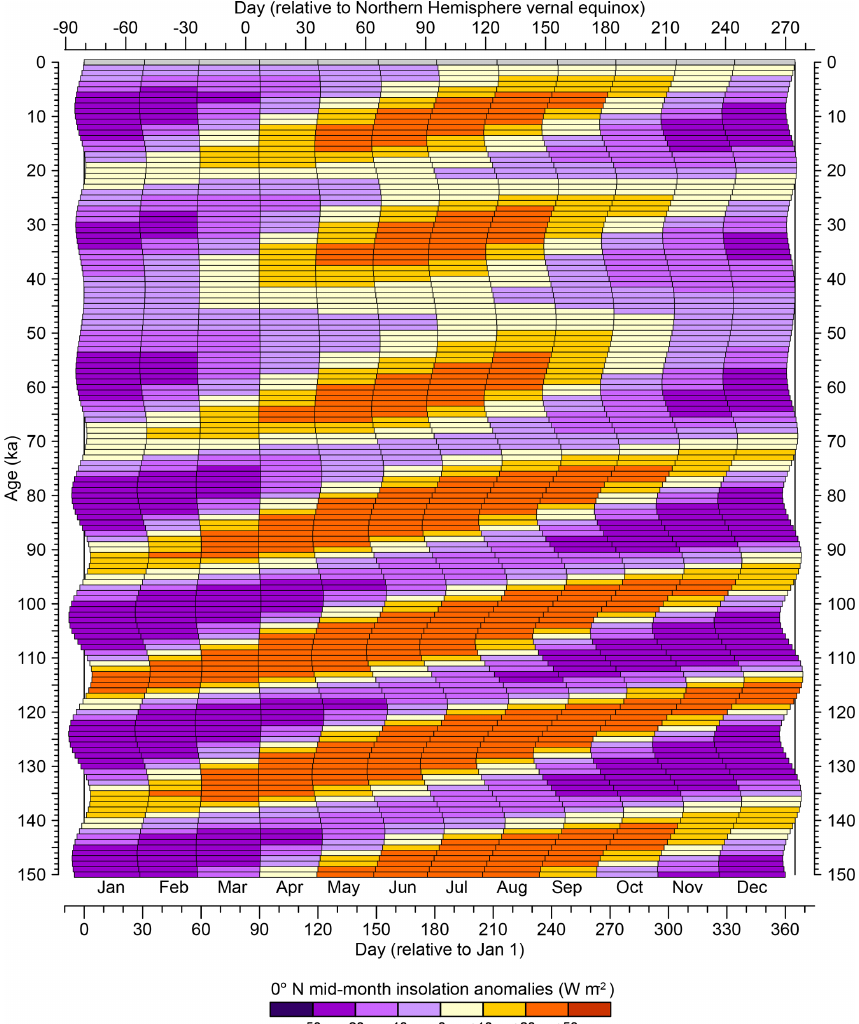
Figure 8. Long-term differences in mid-month average daily insolation relative to present (0ka or 1950 CE) at the Equator for a fixed-angular calendar. As in Fig. 1, variations over the past 150kyr in the beginning and ending days of fixed-angular months for a 365d noleap calendar are shown for 1kyr intervals beginning at 0ka (1950 CE). The left side of each horizontal bar shows the beginning day, while the right side shows the ending day of a particular month for each 1kyr